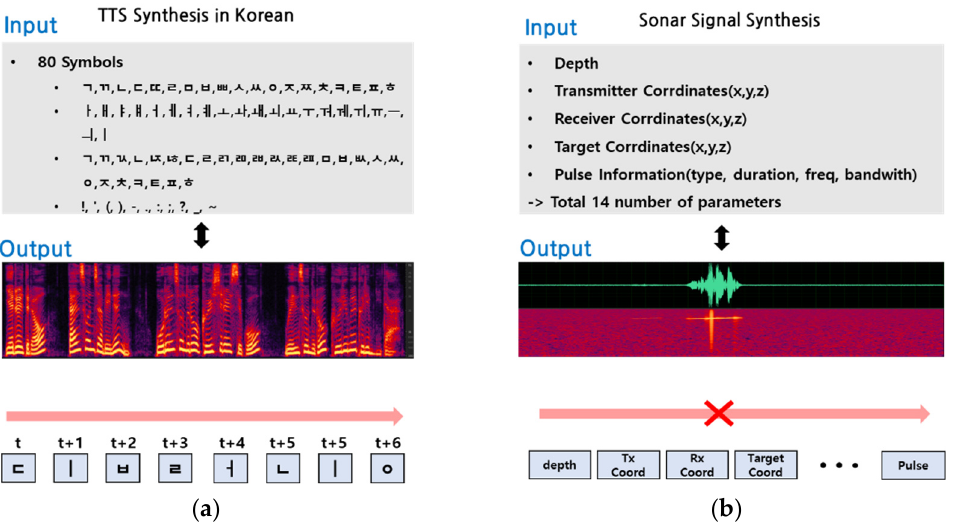
Figure 4. Input and output configuration. ( a ) The input/output structure of the TTS model. A total of 80 symbols are arranged in time order. ( b ) The input/output structure of the proposed sonar signal synthesis model. Fourteen marine environmental parameters are arranged regardless of time order.